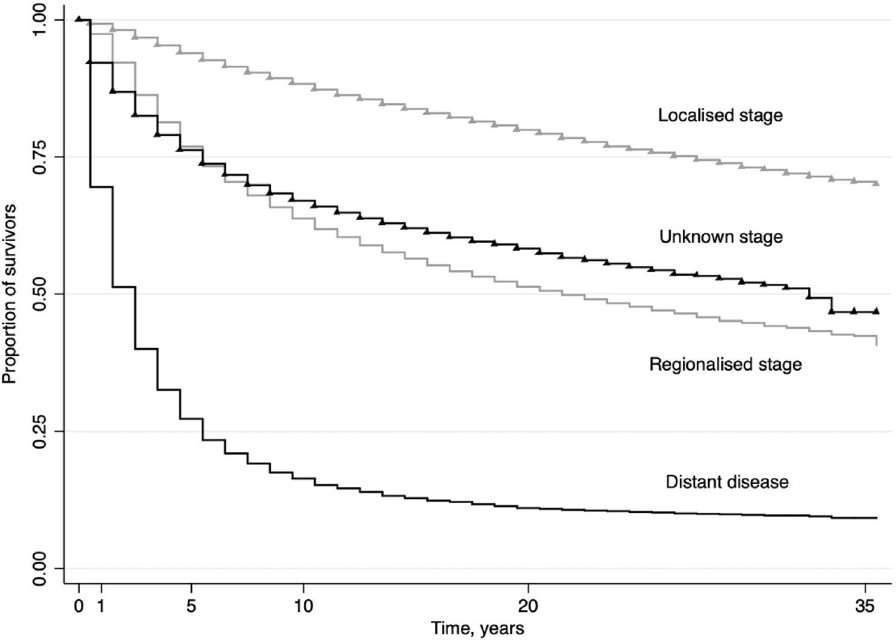
Figure 5. Kaplan–Meier estimates for breast-cancer specific survival in female patients in Austria according to stage at diagnosis 1983–2017.